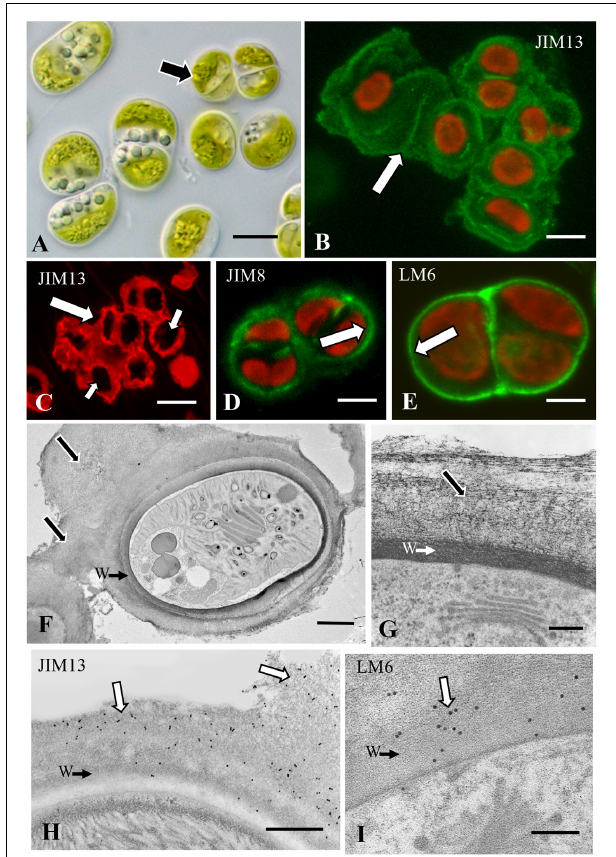
FIGURE 2 | Chlorokybus : (A) DIC image of Chlorokybu s showing unicellular or sarcinoid packet form (arrow). Bar 6.5 µ m. (B) JIM13 immunofluorescence demonstrating labeling in an extracellular sheath (arrow). Bar 6.0 µ m. (C) JIM13 immunofluorescence CLSM image showing the extensive extracellular sheath both around and between cells (large arrow). The cells are the dark zones within the packet sheath (small arrows). Bar 9.0 µ m. (D) JIM8 labeling of the cell wall (arrow). Bar 7.0 µ m. (E) LM6 labeling of the cell wall (arrow). Bar 4.5 µ m. (F) TEM image of a cell in a sarcinoid packet. Note the cell wall (CW → ) surrounded by the extensive extracellular sheath (arrows). Bar 4 µ m. (G) Magnified TEM image of the ECM showing the cell wall (CW → ) and extracellular sheath (arrow). Bar 500 nm. (H) JIM13 immunogold labeling of the extracellular matrix (ECM, arrows), labeling of the cell wall very limited (CW → ). Bar 700 nm. (I) LM6 labeling of the cell wall (arrow) and interface of the wall (W → ) with the ECM. Bar 800